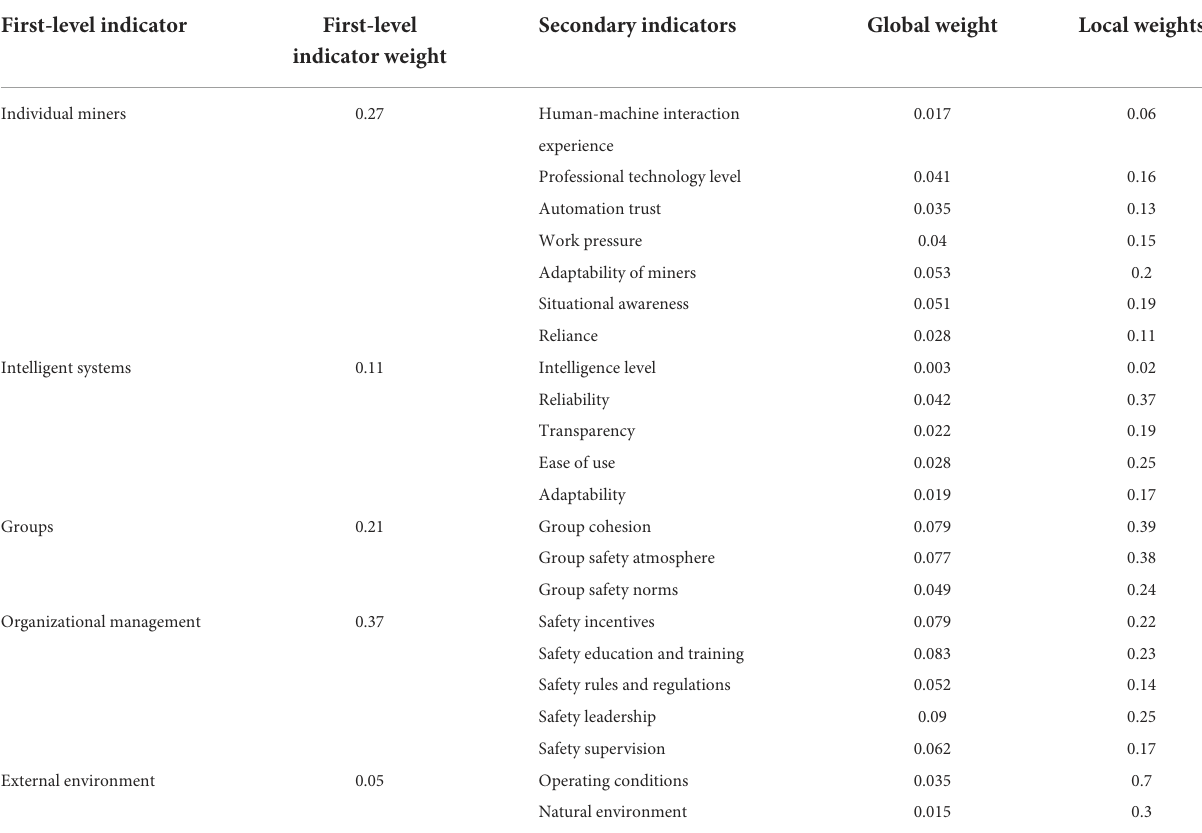
TABLE 1 ANP weight calculation